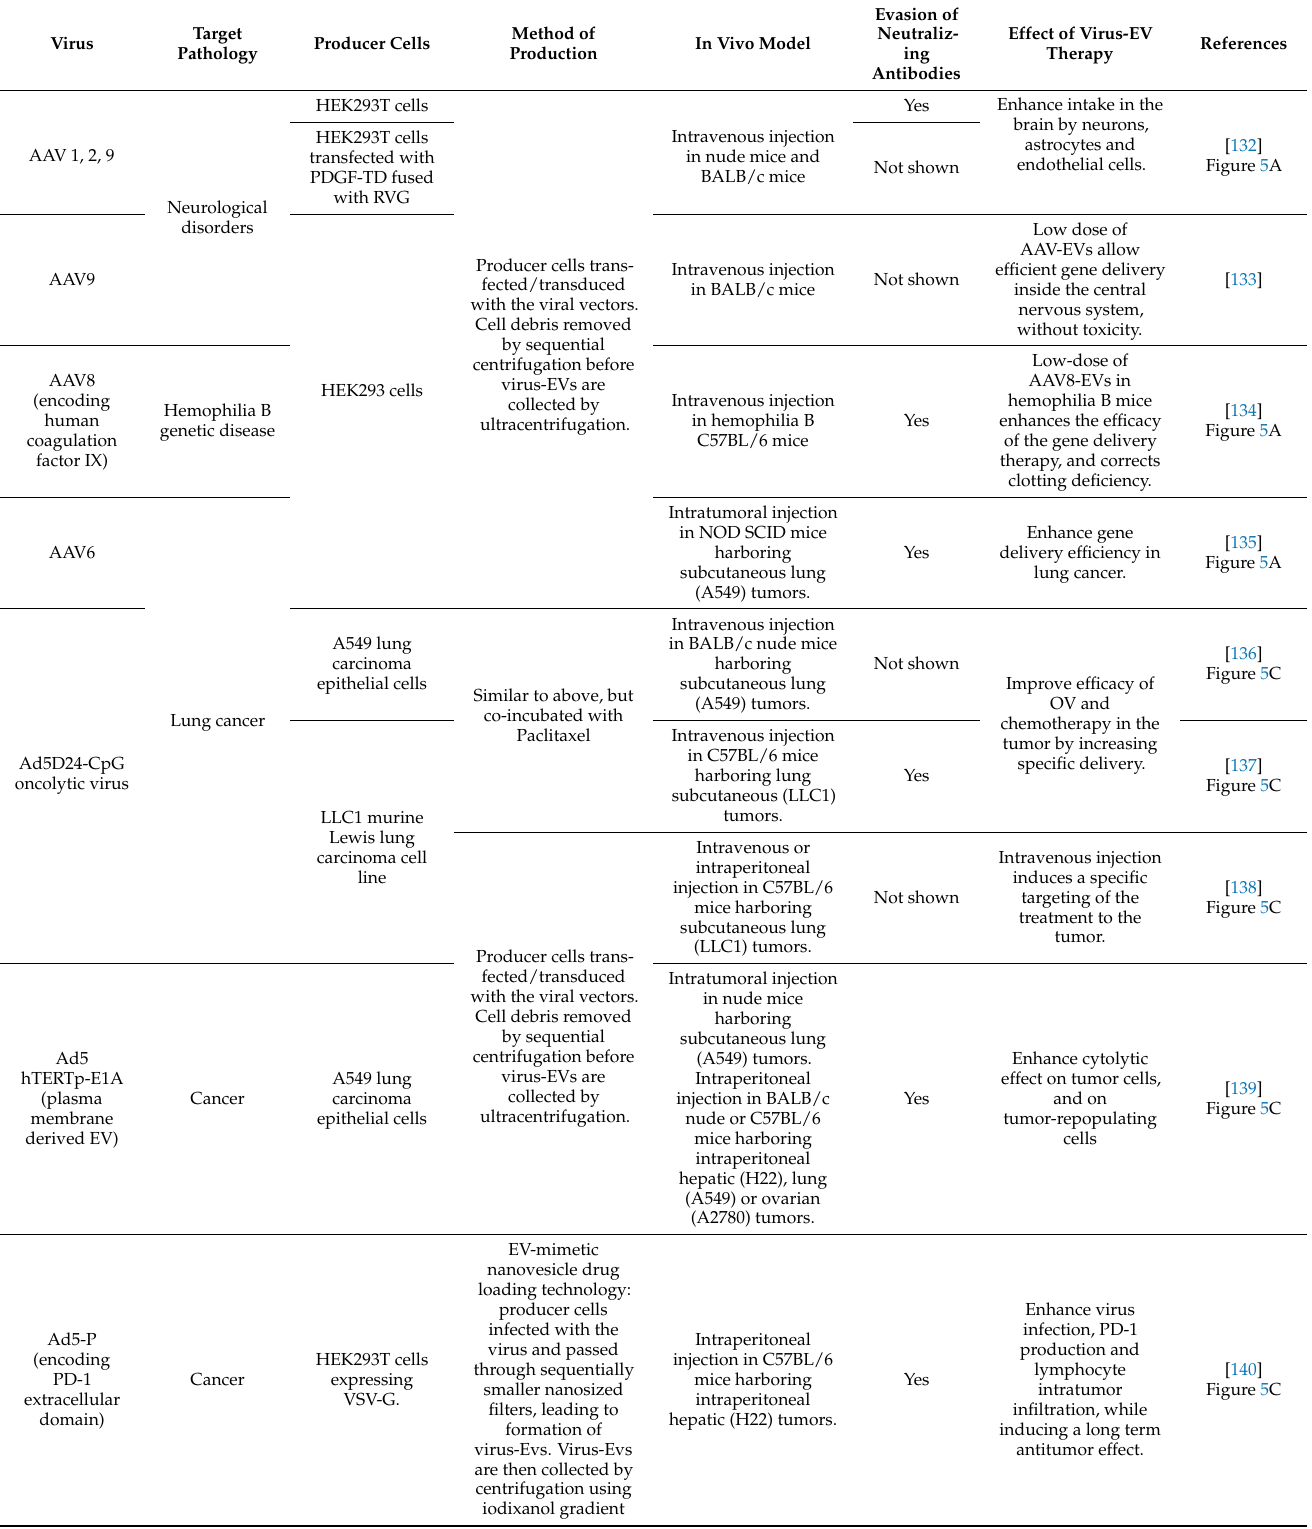
Table 2. Summary of Virus-EV